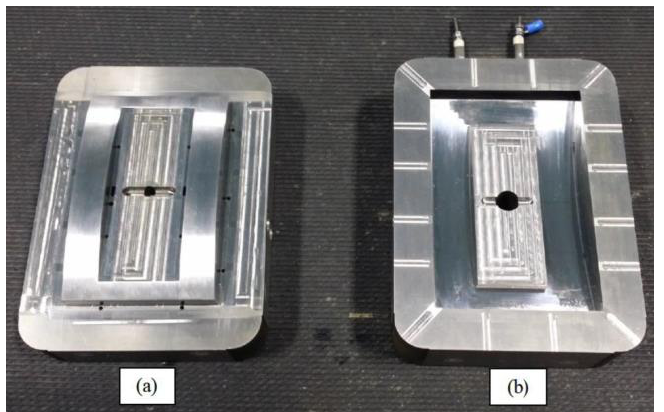
Figure 8. Mould inserts for front panel housing using straight drilled cooling channels, ( a ) core insert, ( b ) cavity insert.